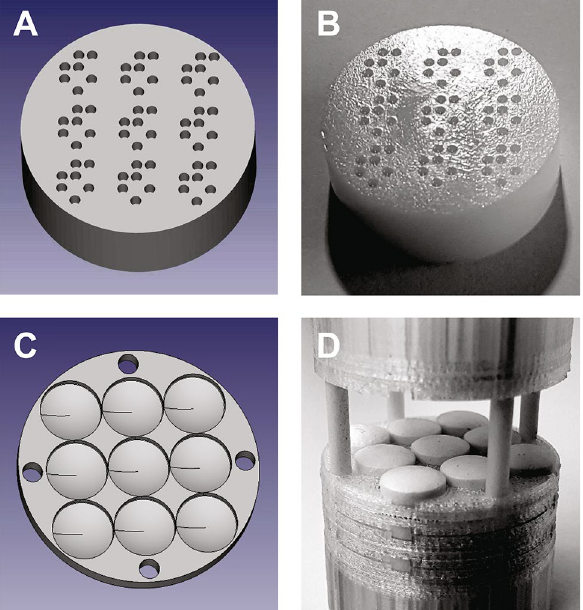
Figure 6. Tested periodic samples. ( A ) Computer model of the JSI logo test sample and ( B ) its realization made of POM plastic. 1.2 mm holes in the sample are oil-filled. The JSI logo sample has a 2D translational symmetry and consists of 9 unit cells of 7 × 7 mm 2 in size that are arranged in a 3 × 3 matrix. ( C ) Computer model of a tablet holder segment, ( D ) partially opened sample holder loaded with 27 Aspirin Protect tablets in 3 layers. Each layer was covered from top and bottom with one holder segment. The periodic tablet sample has a 3D translational symmetry and 7.6 × 7.6 × 3.93 mm 3 unit cells arranged in a 3 × 3 × 3